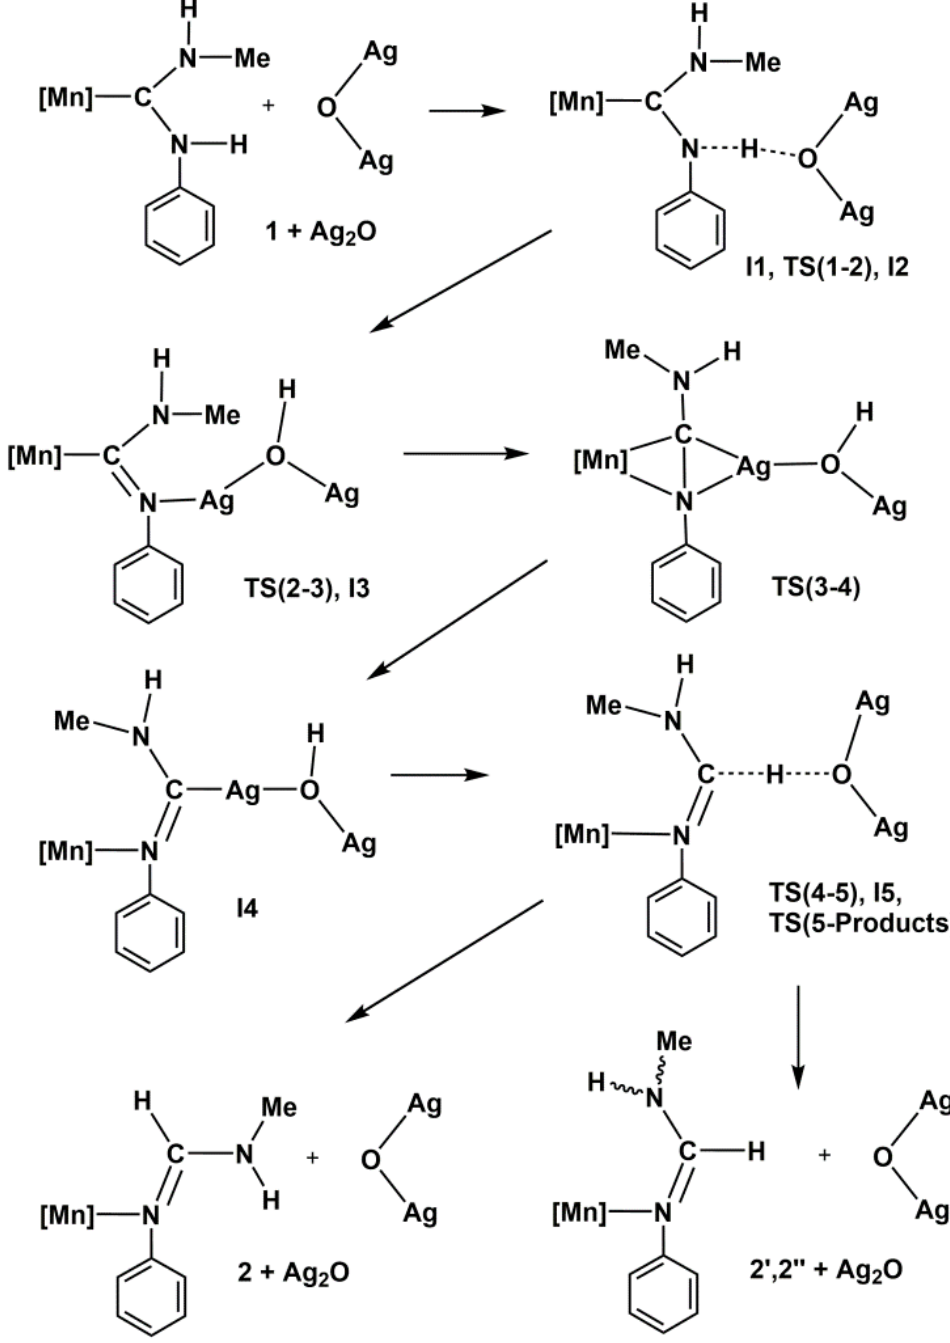
Scheme 2. Proposed mechanism for the isomerization of the diaminocarbene ligand in complex 1 to formamidine, catalyzed by Ag 2 O. [Mn] = [Mn(CO) 3 (bipy)] +